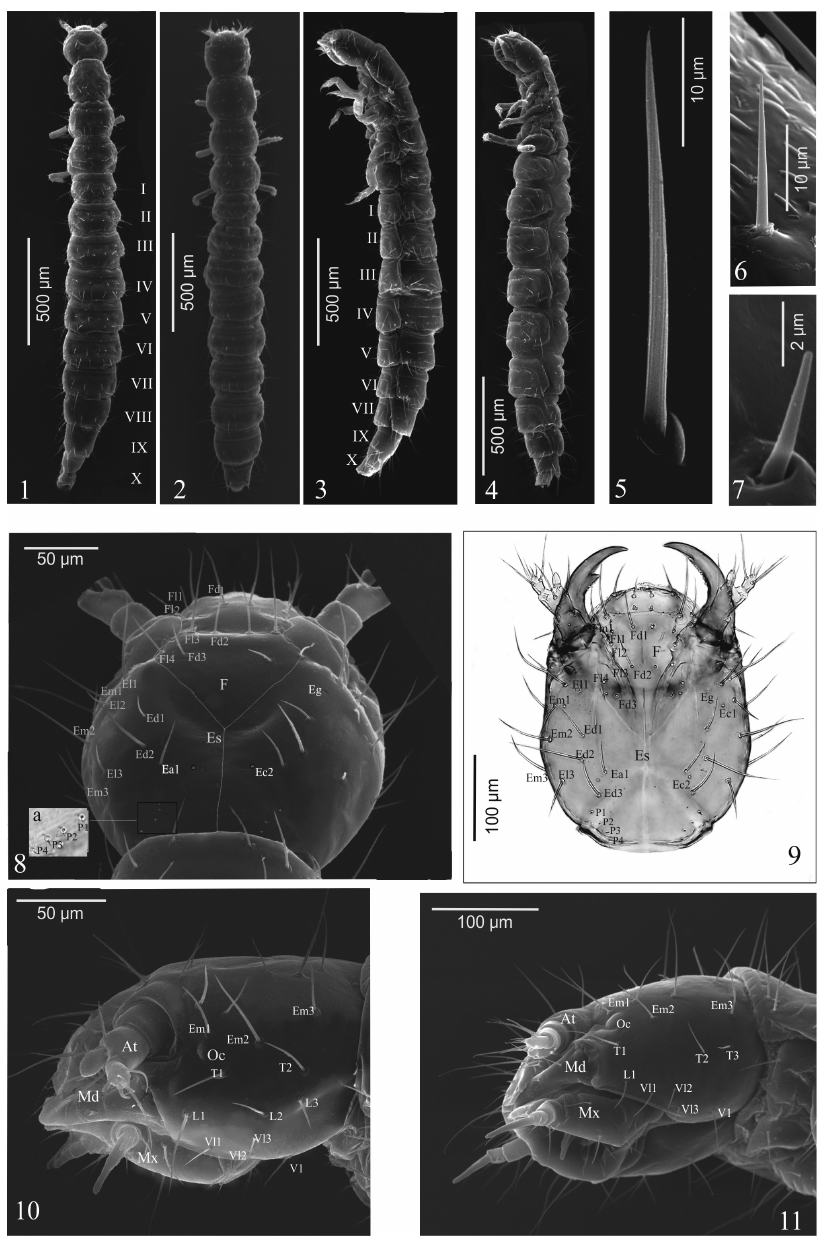
11 ) aspect. Abbreviations: I-X, abdominal segments; At, antenna; Ec, epicranial campaniform sensilla; Ed, epicranial dorsal setae; Eg, epicranial gland; El, epicranial lateral setae; Em, epicranial marginal setae; Es, epicranial suture; F, frons; Fd, frontal dorsal setae; Fl, frontal lateral setae; L, lateral setae; P, posterior setae; T, temporal setae; V, ventral setae; Vl, ventral lateral